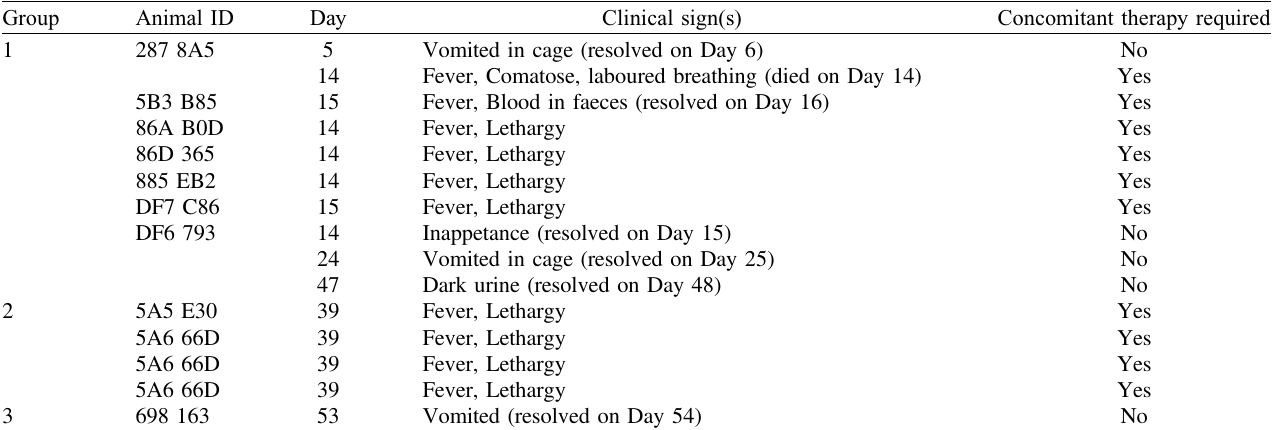
Table 1. Signs reported during the daily health observations.